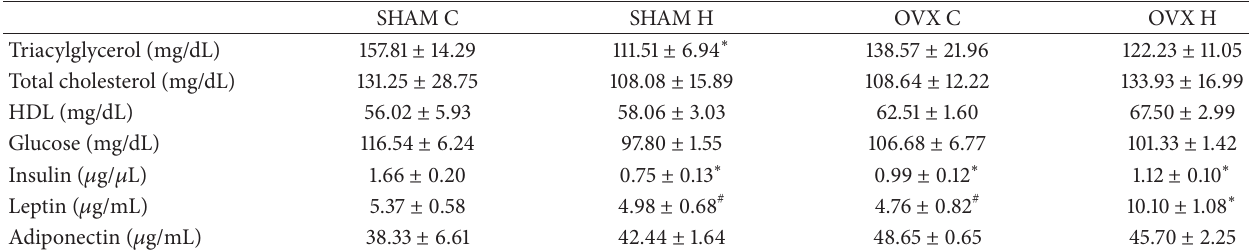
Table 3: Serum triacylglycerol, total cholesterol, HDL-cholesterol, glucose, insulin, leptin, and adiponectin of studied rats groups. SHAM C SHAM H